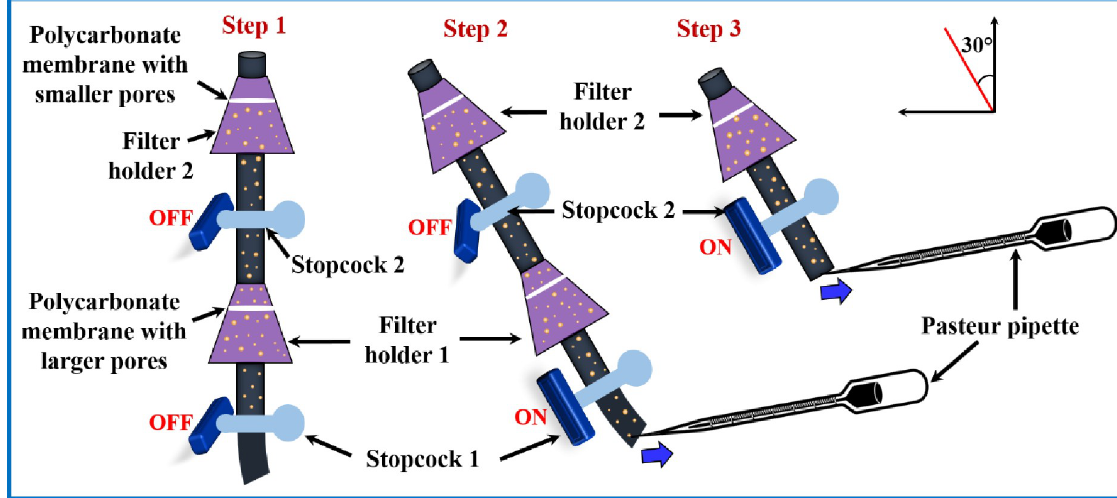
Fig 4. A step wise schematic representation of collecting the purified GUV suspension from the space under filter holder 1 and filter holder 2. Step 2 is the process of collecting the purified GUV suspension for single filtration, while step 3 is the process of collecting the purified GUV suspension for dual